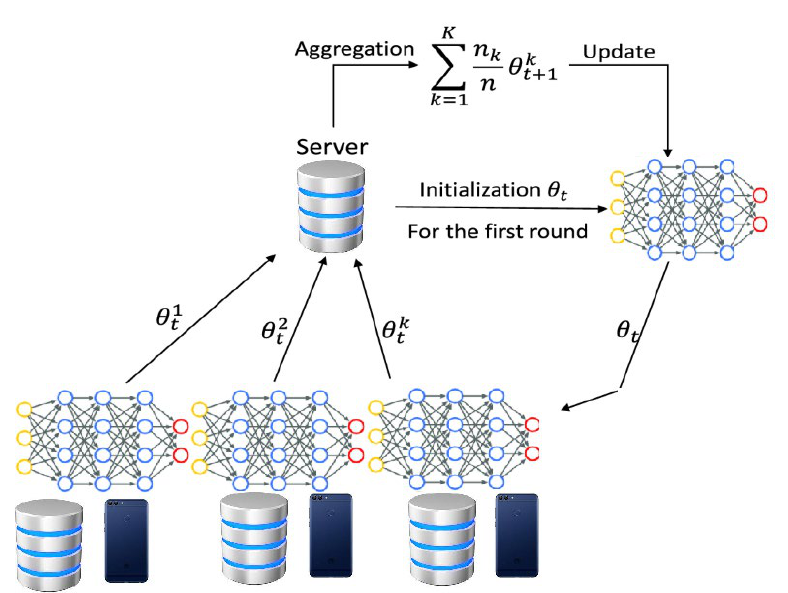
Figure 3. Models are updating in